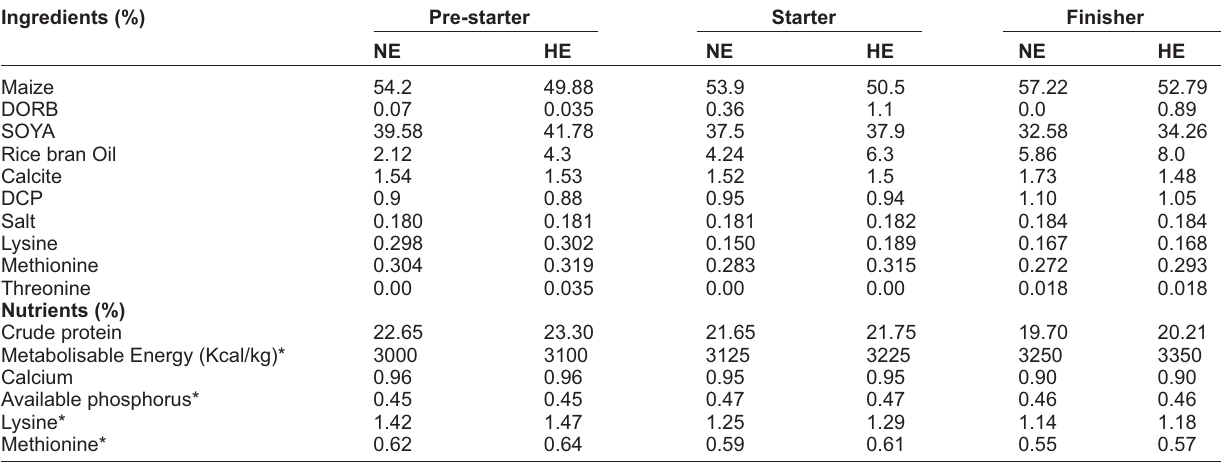
Table-1: Ingredients and nutrients composition (% DM) of broiler pre starter, starter and finisher diets Ingredients (%) Pre-starter